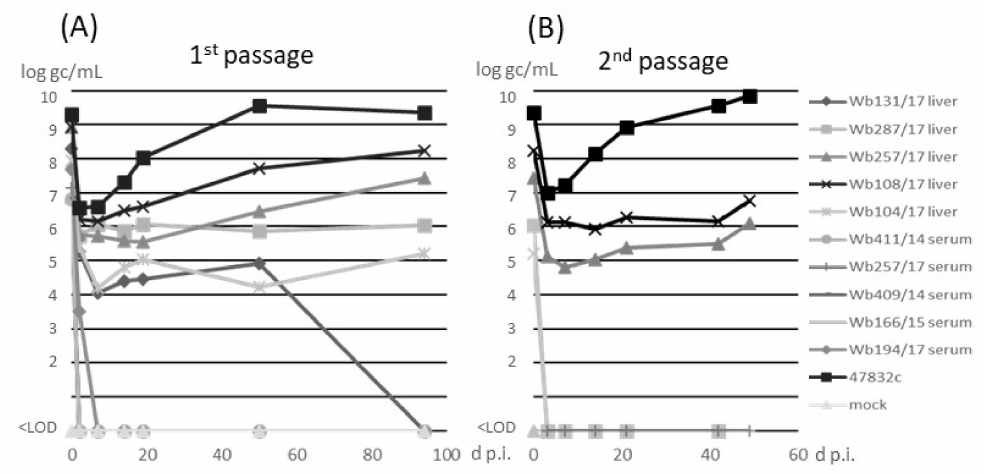
Figure 2. Detection of HEV RNA in cell culture supernatant after ( A ) inoculation of PLC/PRF/5 cells with wild boars samples (1st passage) or ( B ) inoculation of the supernatants from 96 days post-infection (d p.i.) of the 1st passage on fresh PLC/PRF/5 cells (2nd passage). Supernatants of first and second passage were analyzed by RT-qPCR and the amounts are shown in log genome copies (gc)/mL. <LOD, below limit of